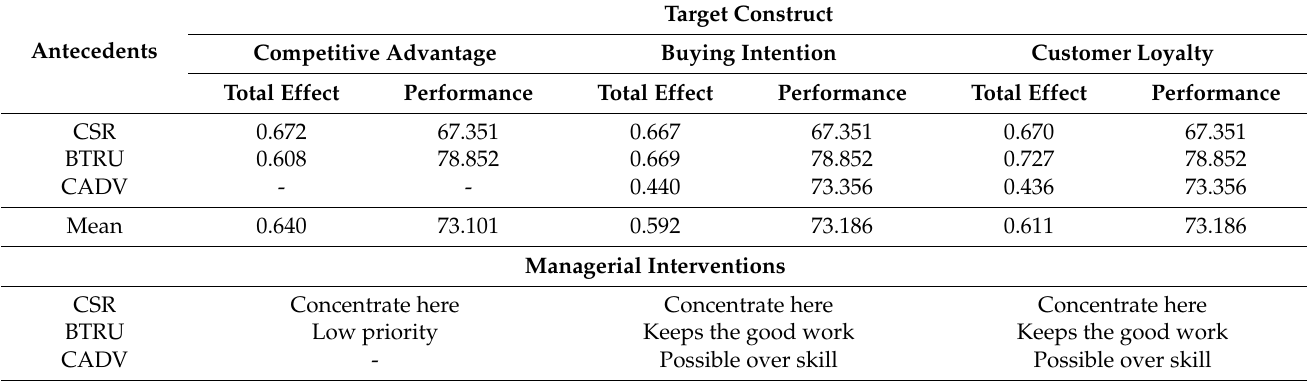
Table 8. Importance–Performance